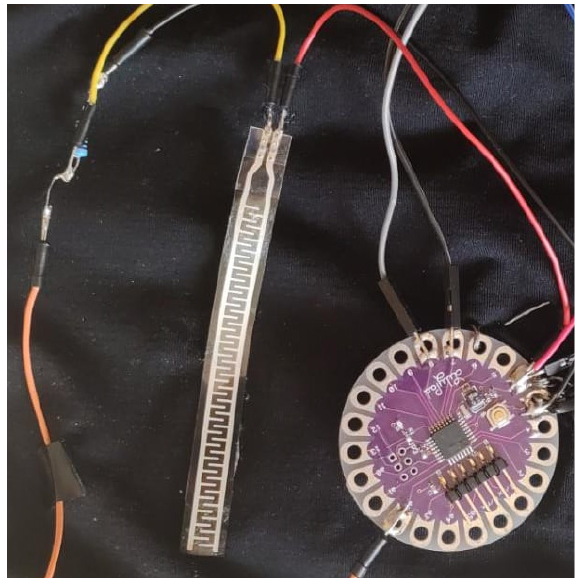
Figure 3. Photograph of the system key elements, the Lilypad board and the flex sensor, as integrated in the garment.